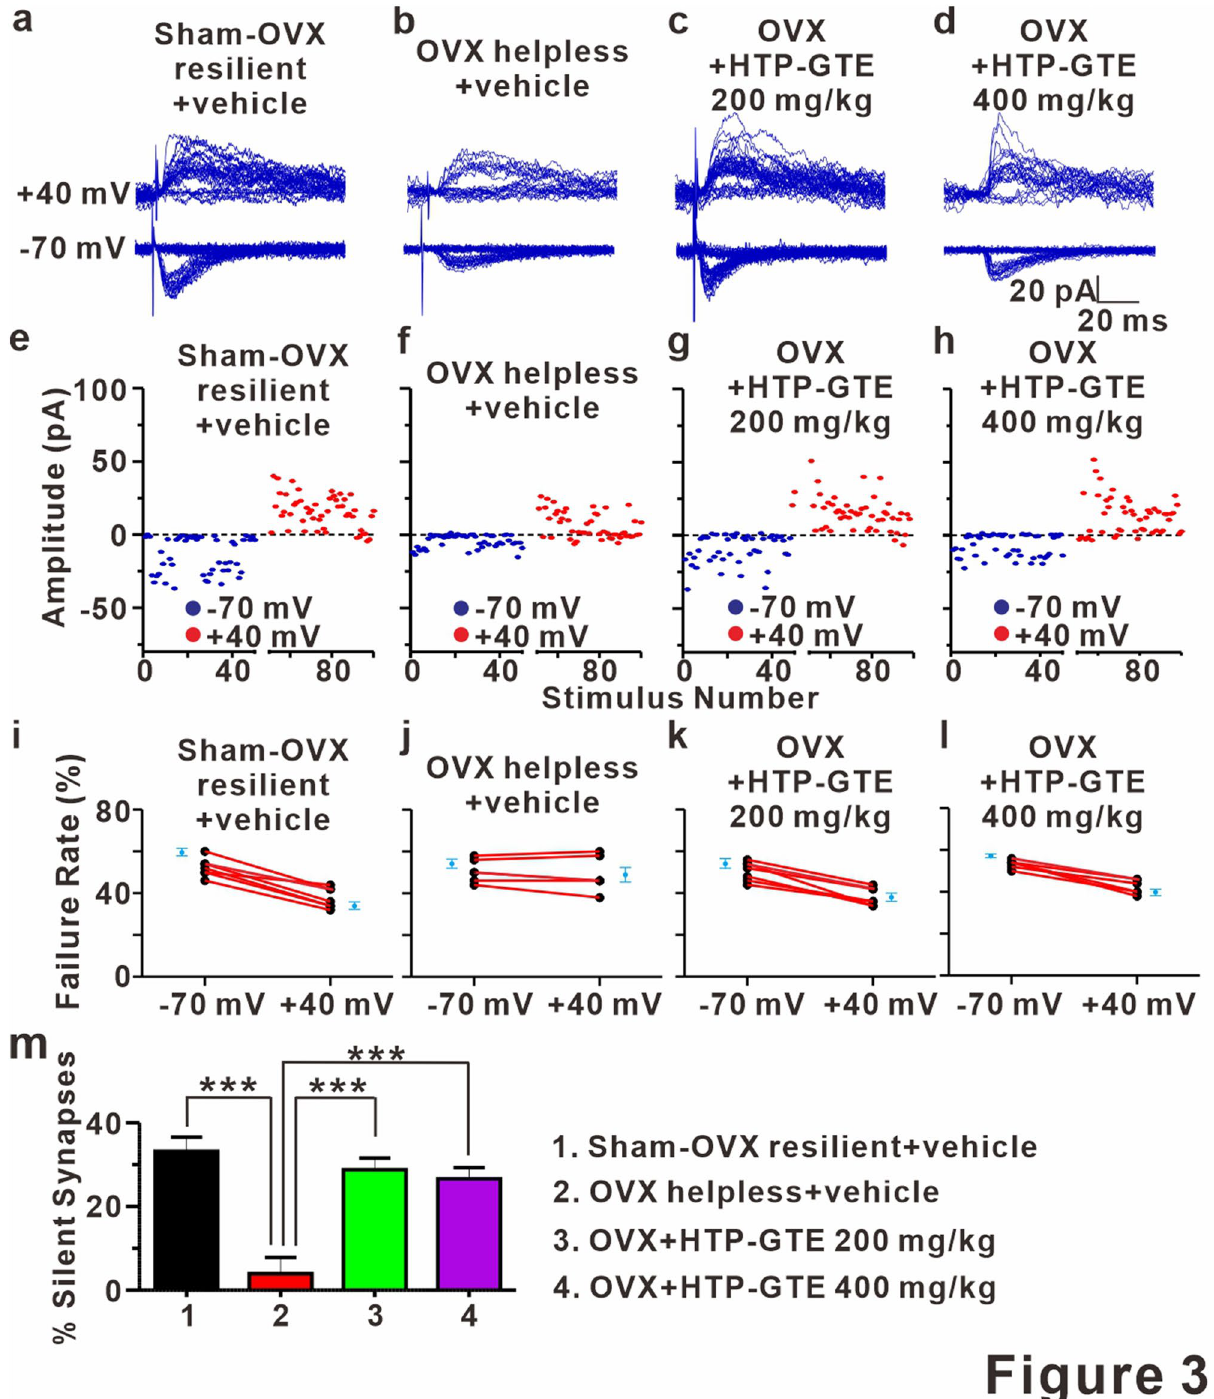
Figure 3. Silent synapses are re-emerged following HTP-GTE administration in OVX rats. ( a-d ) Representative traces for EPSCs evoked by minimal stimulation for 50 trials at holding potentials of -70 mV or + 40 mV in the slices from sham-OVX resilient + vehicle, OVX helpless + vehicle, OVX + HTP-GTE 200 mg/kg, and OVX + HTP-GTE 400 mg/kg groups. ( e–h ) Time course of EPSC amplitudes in representative cells shown in collected -70 mV (blue symbols) and + 40 mV (red symbols). ( i–l ) Failure rates for EPSCs at − 70 mV or + 40 mV in slices for all groups. ( m ) Percentage of silent synapse proportions for all groups (Sham-OVX resilient + vehicle: 33.19 ± 3.38, n = 7; OVX helpless + vehicle: 3.925 ± 3.89, n = 6; OVX + HTP-GTE 200 mg/kg: 28.78 ± 2.82, n = 7; OVX + HTP-GTE 400 mg/kg: 26.63 ± 2.67, n =